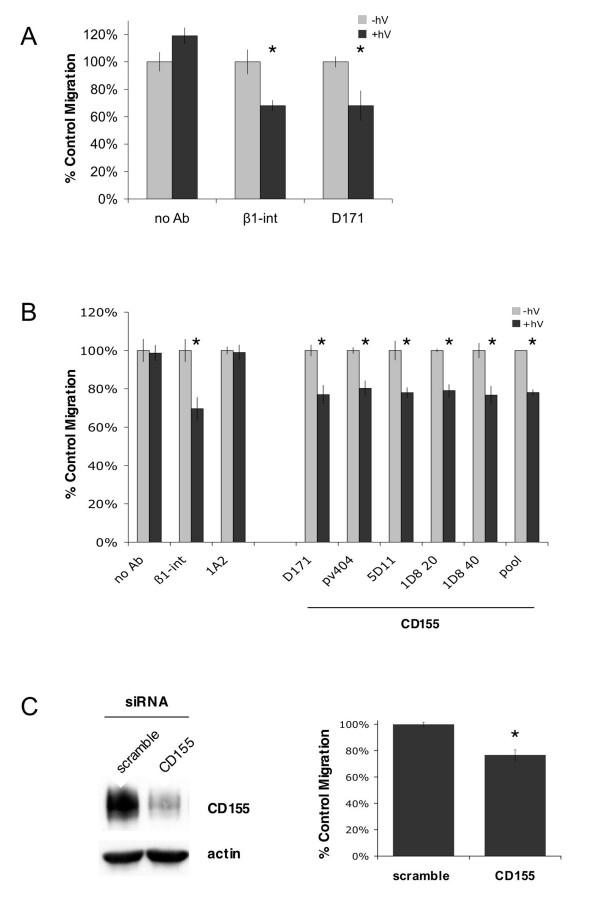
CD155 mediates tumor cell invasion and migration. (a) FALI of CD155 resulted in a significant inhibition of HT1080 transwell invasion through matrigel towards a serum chemoattractant (Δ invasion ± FALI: no Ab 19 ± 6%; β1-int 32 ± 4%; CD155 32 ± 11%). (b) FALI of CD155 using multiple mAbs resulted in a significant inhibition of HT1080 transwell migration towards a serum chemoattractant (Δ migration ± FALI: no Ab l ± 4%; β1-int 30 ± 6%; 1A2 (control, surface binding scFv) 1 ± 3%; CD155: D171 23 ± 4%; pv404 20 ± 3%; 5D11 22 ± 4%; 1D8(20) 21± 2%; 1D8(40) 23 ± 4%; CD155pool 22 ± 1%). FALI with CD155 mAb pools did not yield greater inhibition, suggesting maximal inactivation or that the binders share a common epitope. (c) CD155-specific siRNA duplexes were used to knockdown protein expression by about 90% by 72 h. Knockdown of CD155 in HT1080 cells resulted in a significant decrease in transwell migration compared to control cells transfected with a scrambled duplex (23 ± 4%). * indicates p < 0.01, t-test.